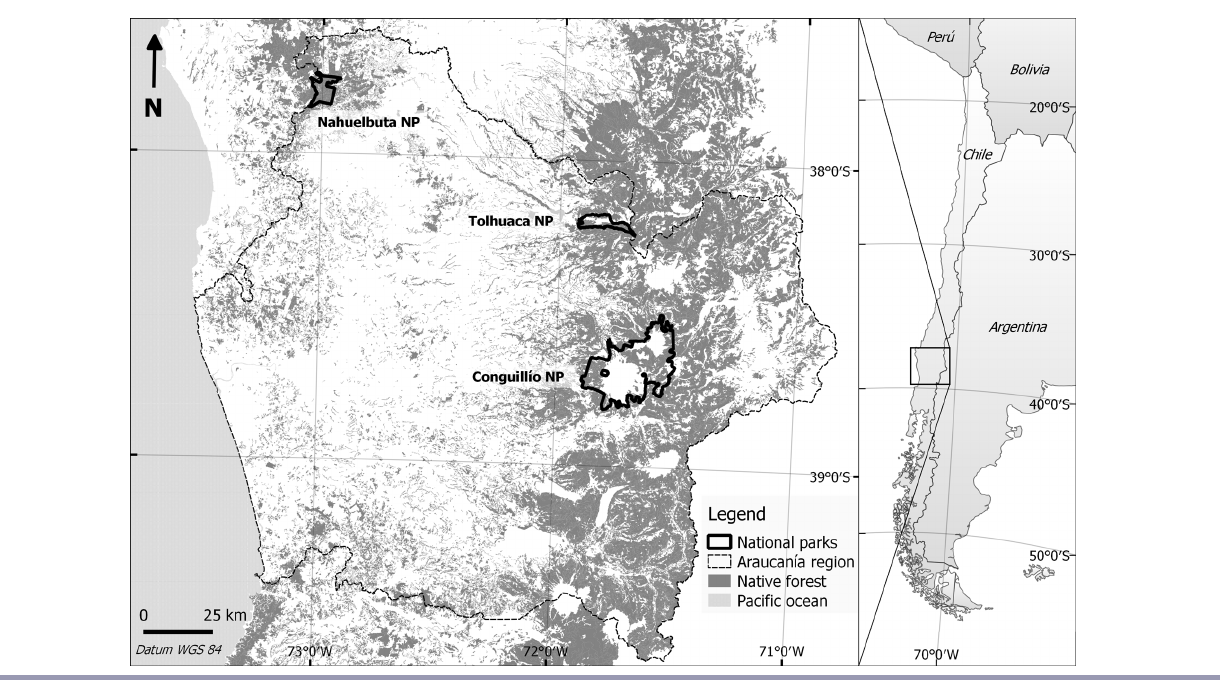
Fig. 1 . Map showing the study national parks, including the remaining native forest (dark gray) and open lands used for forestry or farming (gray). Boundaries represent the limits of the administrative region where the national parks in the study area are located.